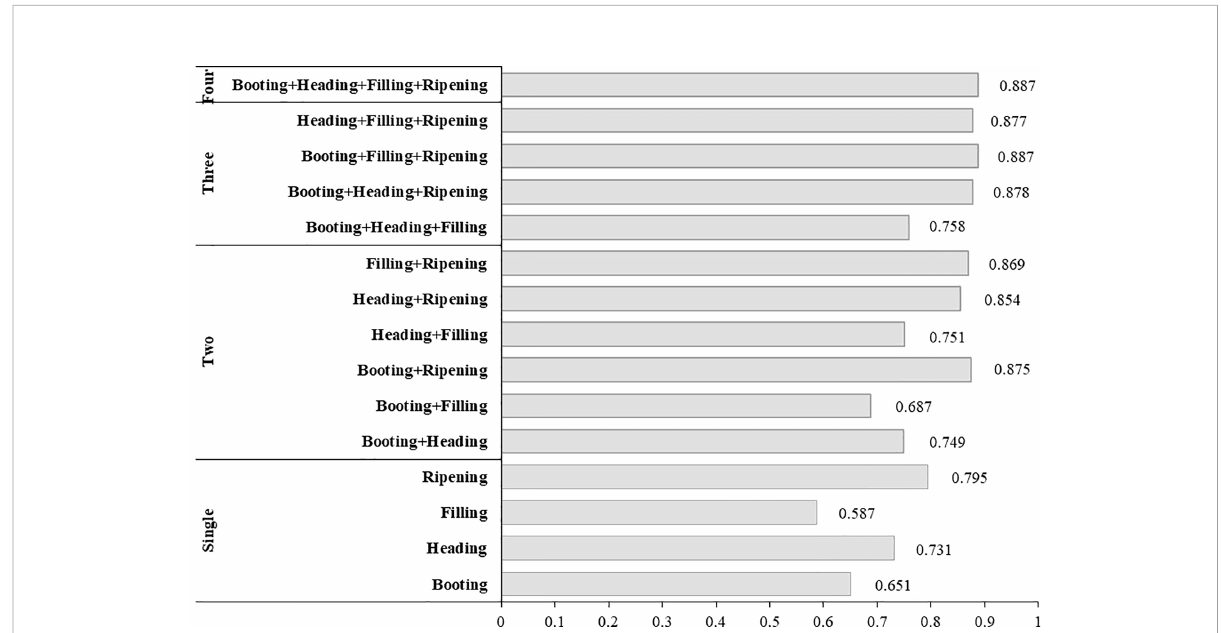
FIGURE 4 Coef fi cient of determination ( R 2 ) of regression models for amylose content (AC) estimation based on spectral variables